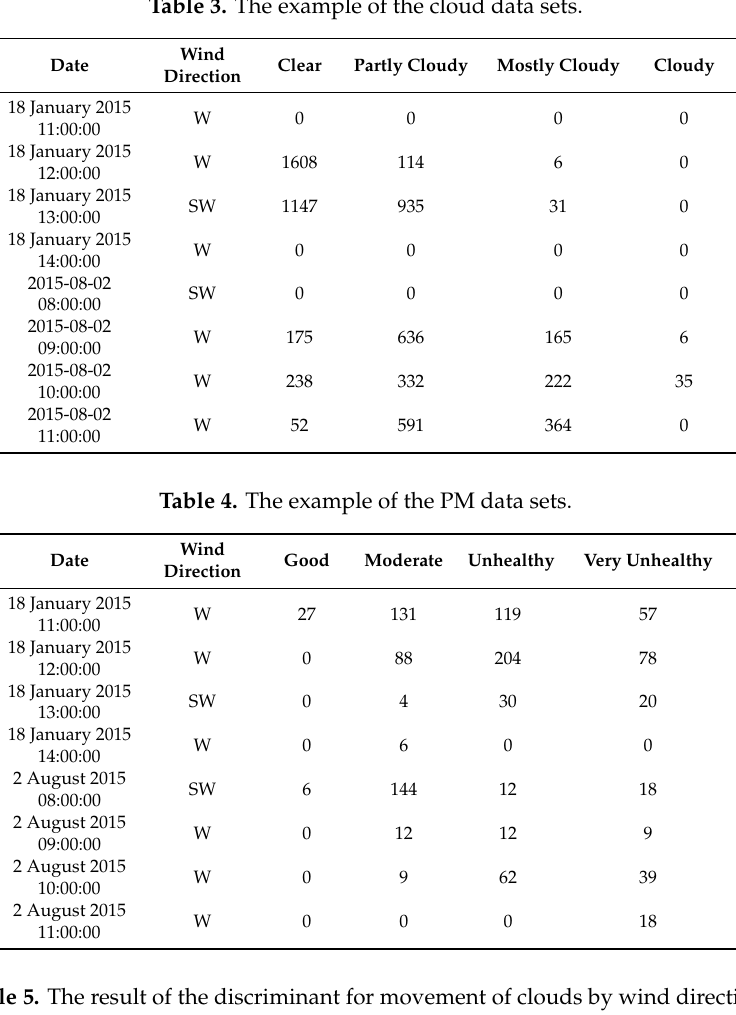
Table 3. The example of the cloud data sets.